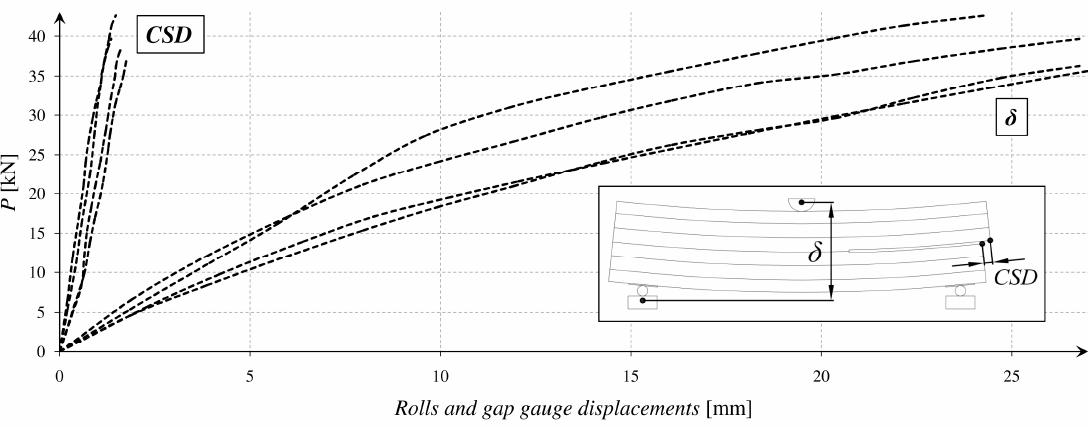
Figure 3. Experimental P( δ ) and P(CSD) relations.